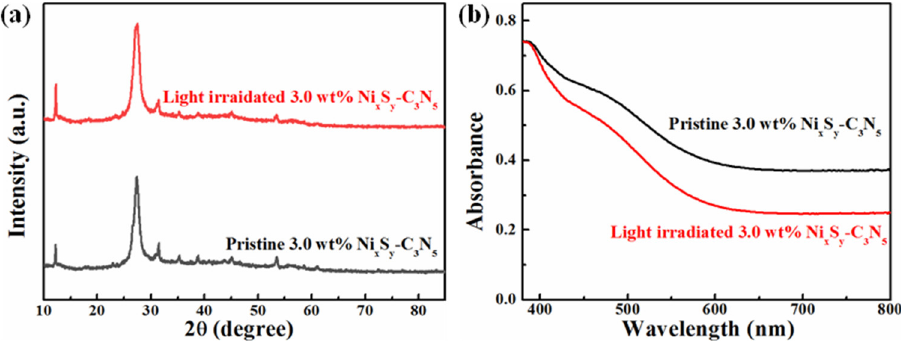
Figure 7. Comparison of ( a ) XRD and ( b ) DRS curves of pristine and light irradiated Ni x S y -C 3 N 5 .